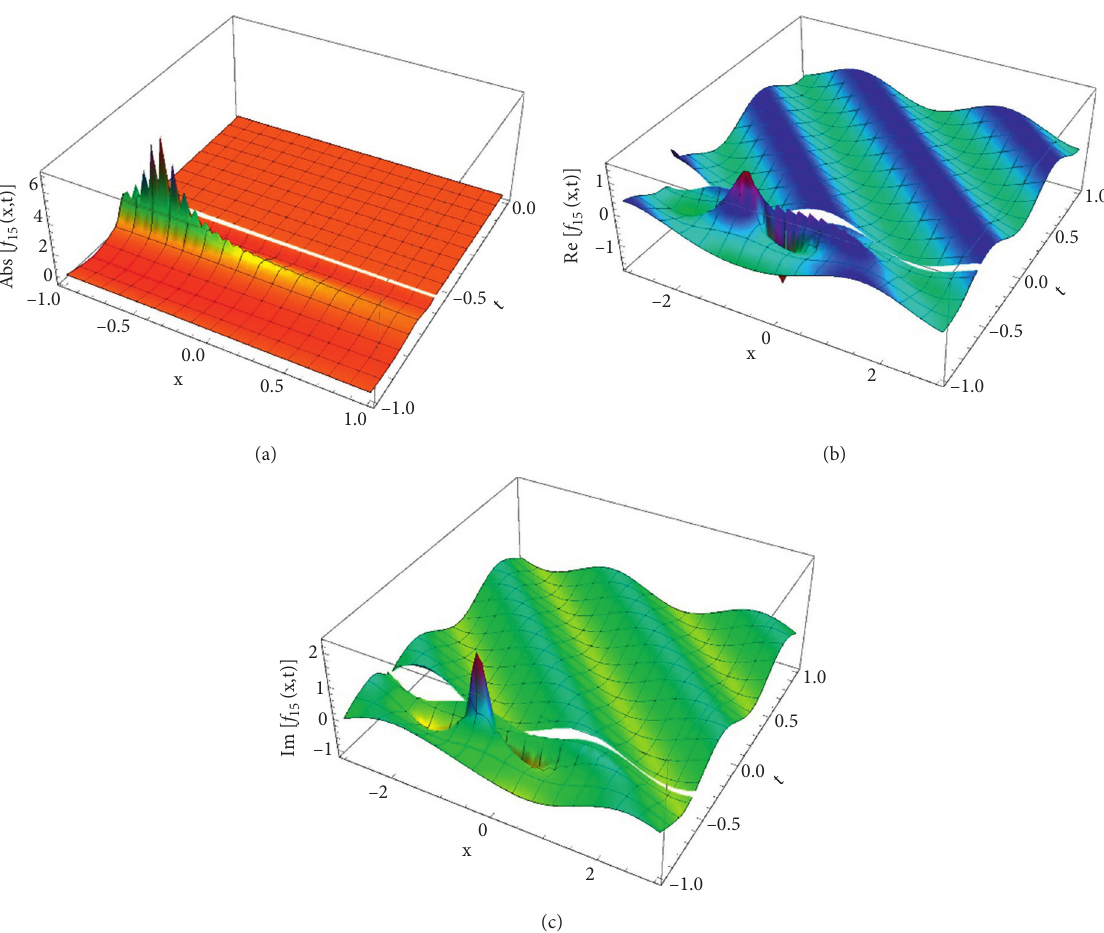
Figure 3: Optical soliton wave solutions of the absolute (a), real (b), and imaginary (c) value of equation (18) in three-dimensional view � 1, A � − 2, a � 4, b � 5, b � − 1, and h � when ( A � 3, c 1 1 0 1